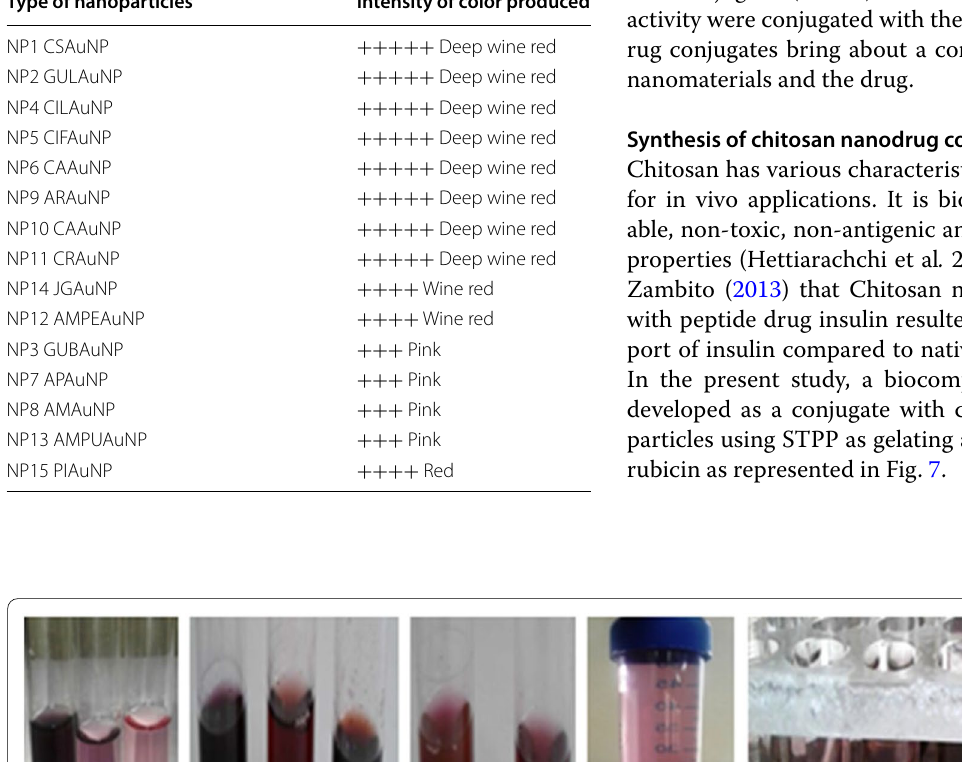
Table 3 Intensity of color in nanoparticles synthesized Type of nanoparticles